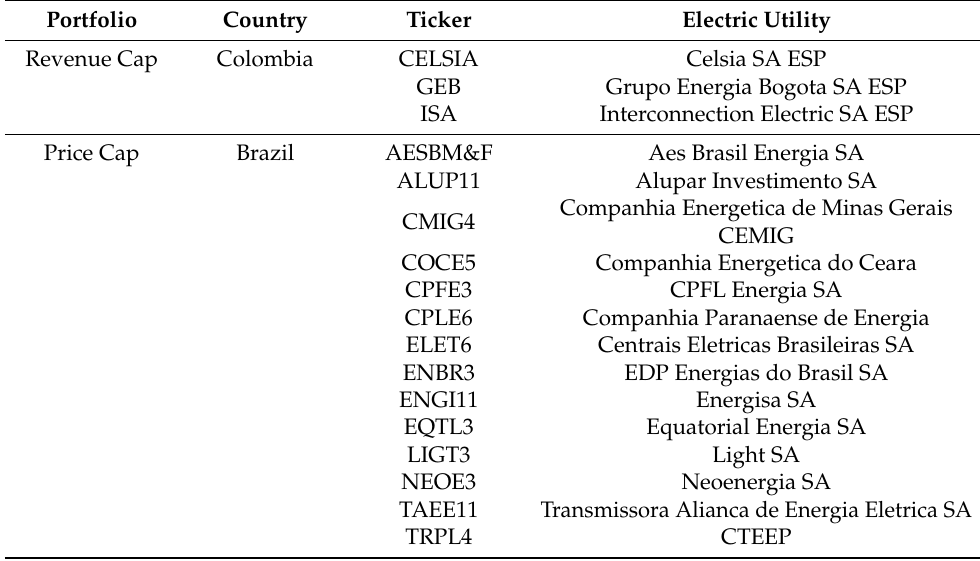
Table 2. Electric utility portfolios. Portfolio Country Revenue